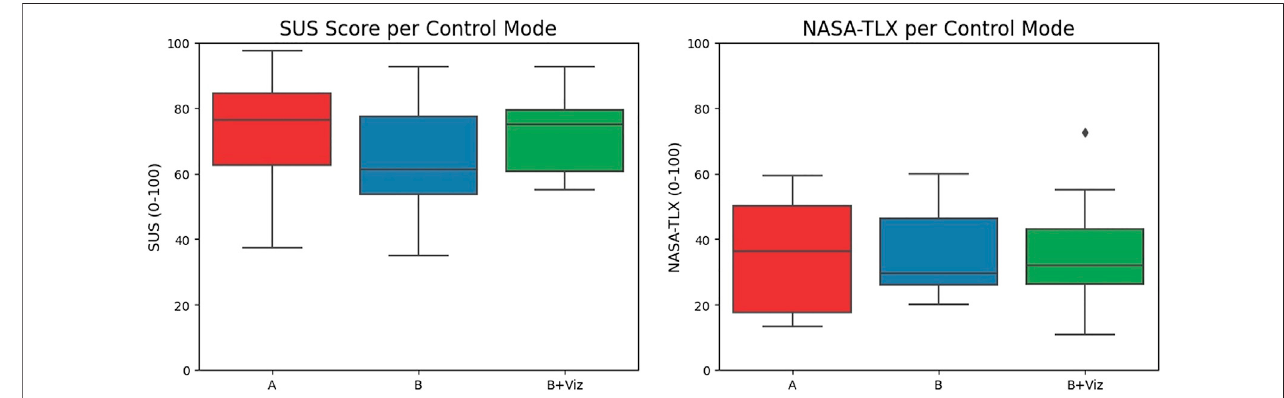
FIGURE 9 | SUS score and NASA-TLX for the screwdriver task using the three different control modes. While the SUS score for shared control without visual feedback (mode “ B ” ) are the lowest rating of usability, there are no signi fi cant differences between the three in perceived workload.